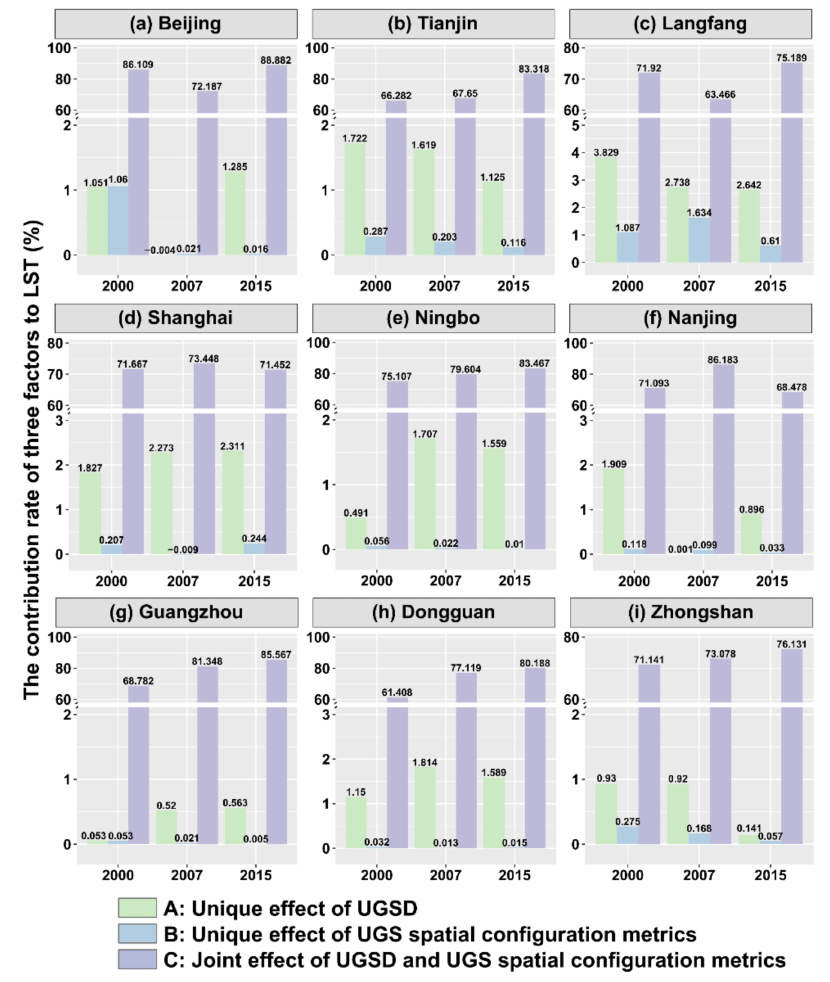
Figure 12. Unique effect of the UGSD and unique effect of the UGS landscape configuration metrics on the LST, and joint effect of the UGS and the UGS landscape configuration metrics on the LST from 2000 to 2015 in different urban sizes and levels considered in this